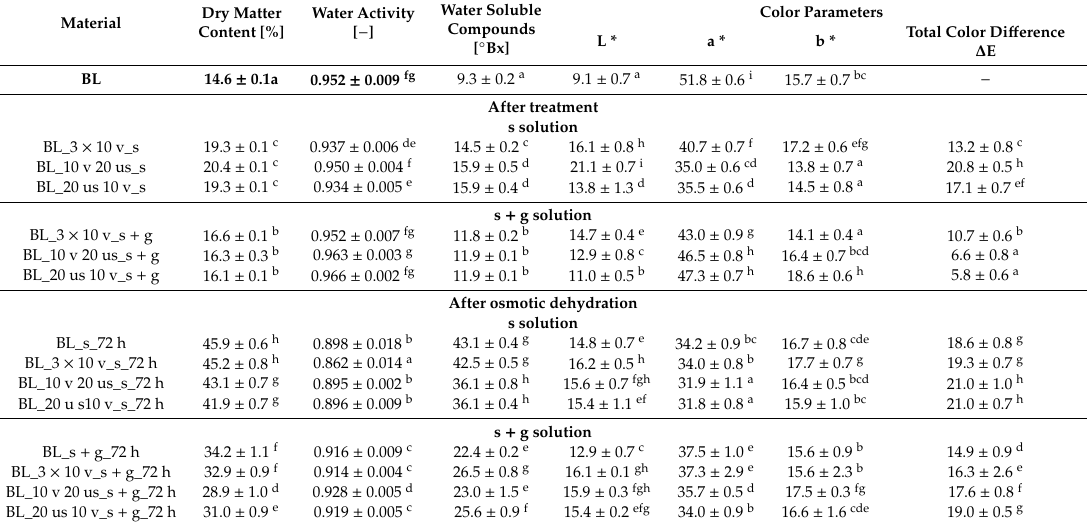
Table 2. Dry matter content, water activity, water soluble compounds, and color parameters in di ff erent treated cranberries, di ff erent letters in columns means significant di ff erence by the Duncan test ( p <